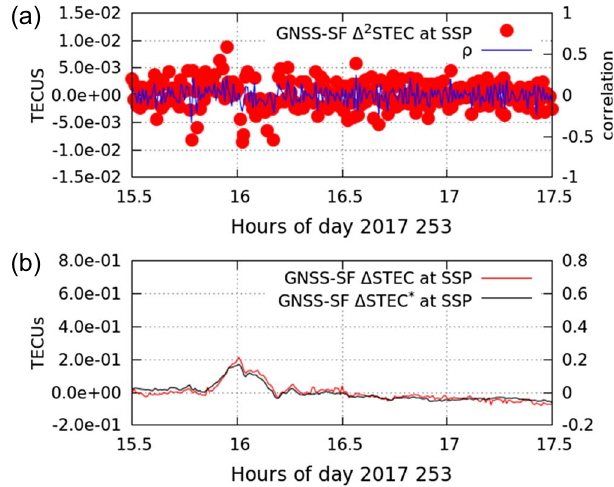
Fig. 17. (a) D 2 STEC (red) and q (blue) at the SSP. (Panel b) from the GNSS data in the case of Figure 13. (b) D STEC and D STEC integrated from D 2